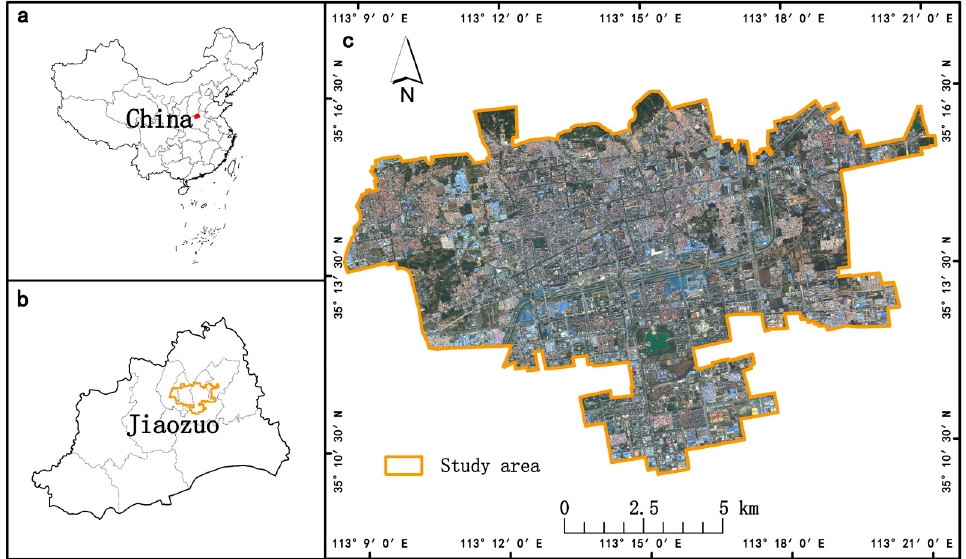
Figure 1. Spatial location of study area. ( a ) location of Jiaozuo in China. ( b ) location of the built-up area in Jiaozuo. ( c ) built-up area in Jiaozuo.